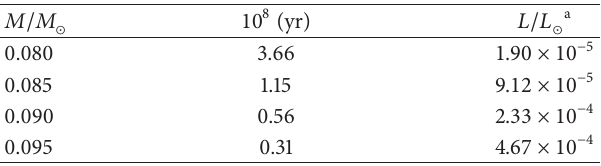
Table 3: Luminosity at the main